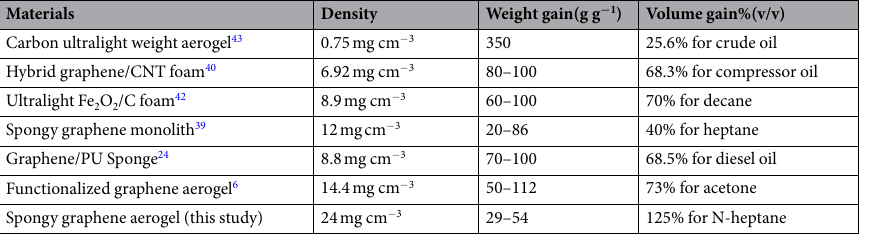
Table 1. Oil absorption capacity (weight gain and volume gain) of various sorbent